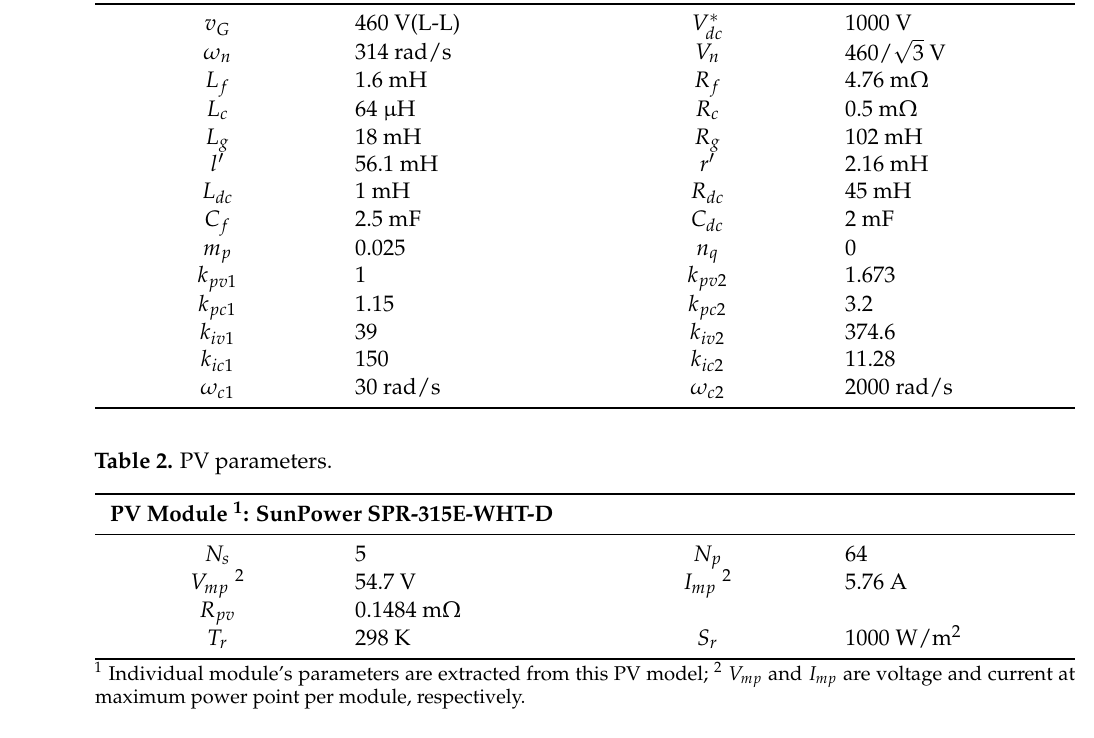
Table 3. SC parameters.